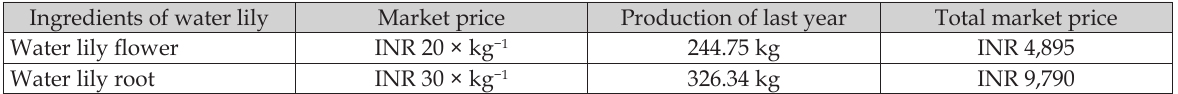
Table 9 . Total valuation of water lily in Suraha Tal Wetland in 2015.